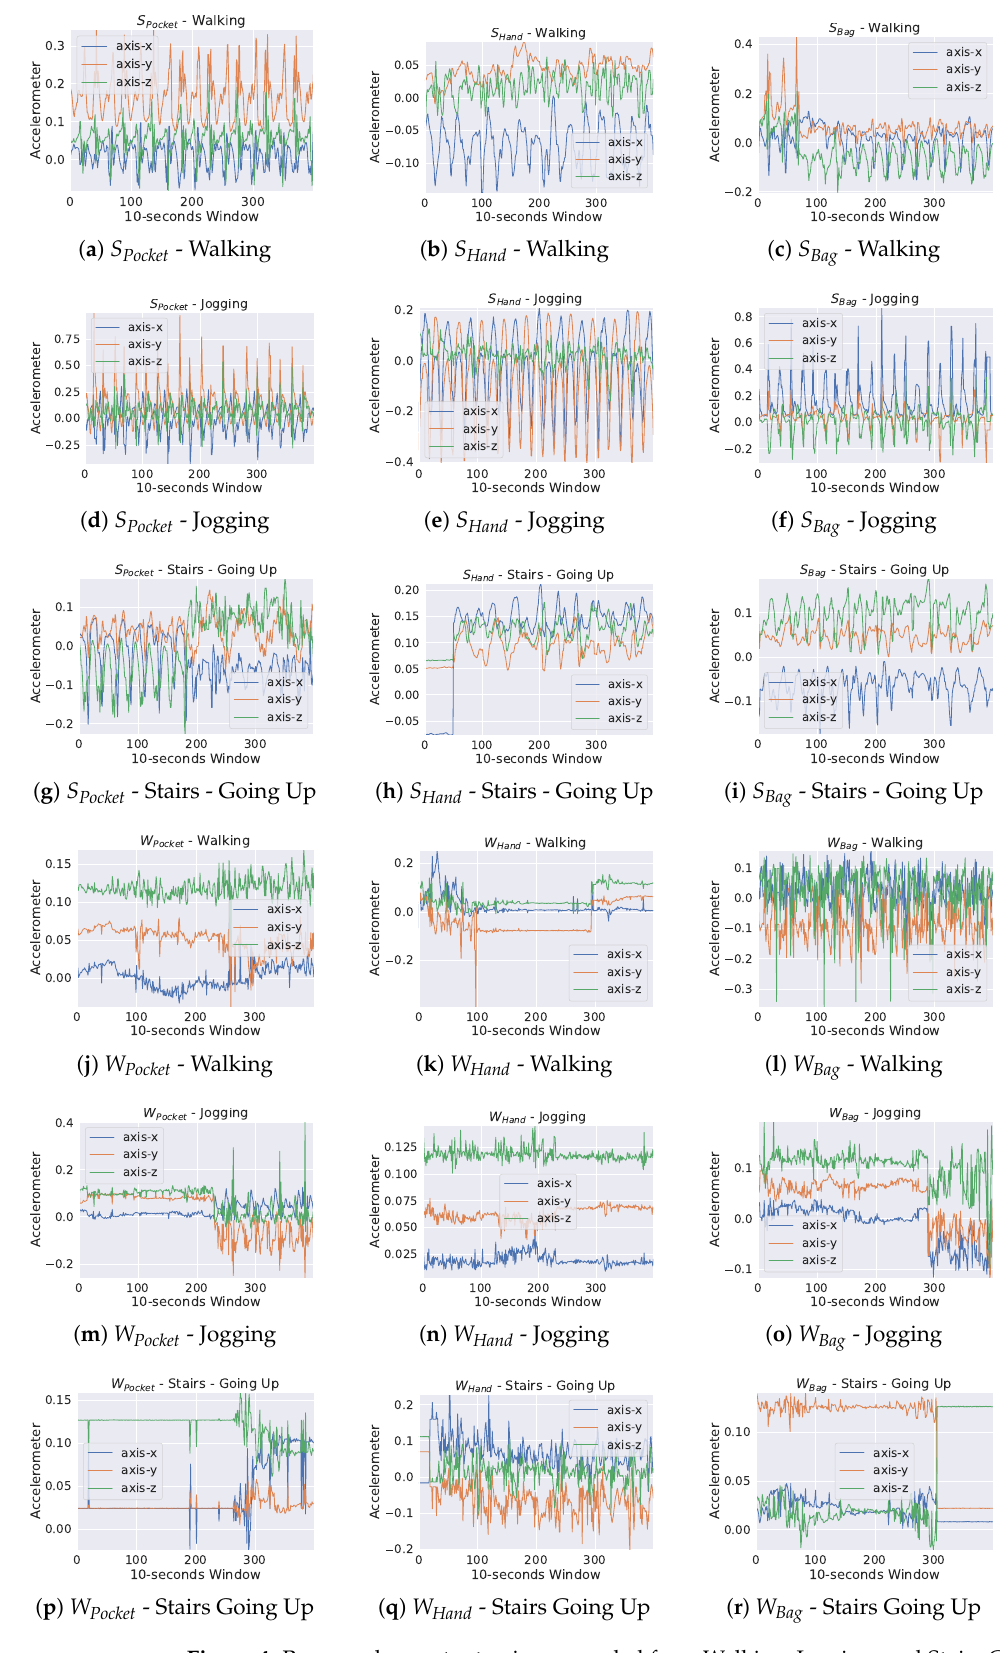
Figure 4. Raw accelerometer tracings sampled from Walking, Jogging, and Stairs Going up